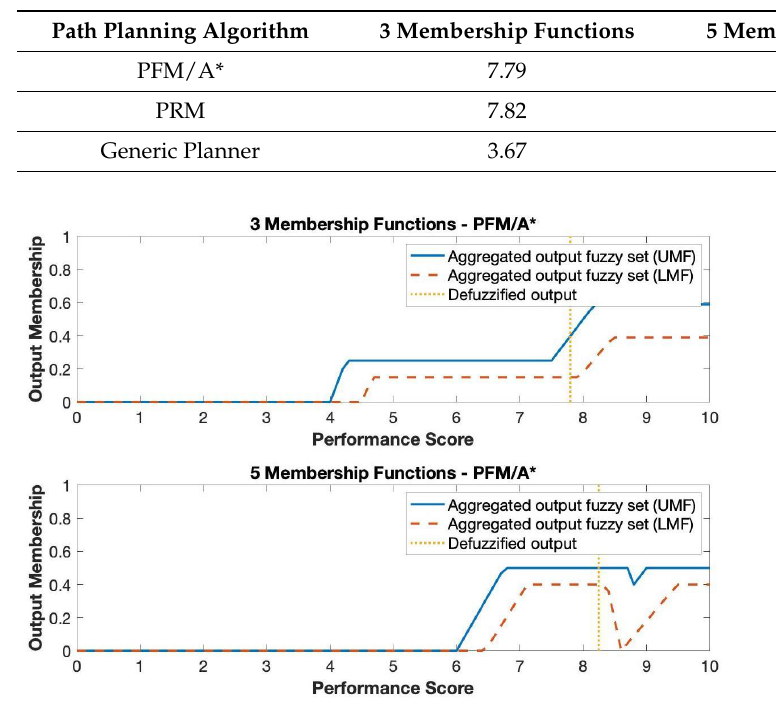
Figure 17. Output set for the PFM/A*